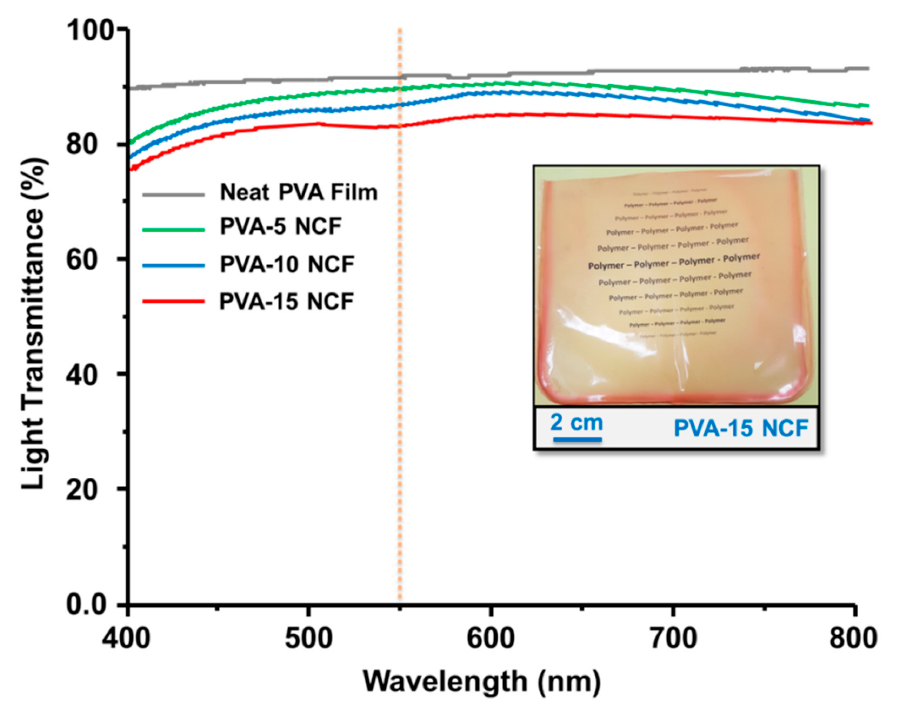
Figure 12. Transmittance for the prepared NCFs. The inset image shows the digital image for the PVA-15 NCFs placed on the top of yellow Xerox paper printed with “Polymer” words. Color parameters for the prepared NCFs at selected pH values are listed in Table 3. The lightness of the NCFs (L*) is almost constant and provides an indication about the absence of color degradation in both acidic and alkaline medium, which reflects the stability of the anthocyanin color at the entire pH range. The a* parameter has positive and high values in the acidic medium in the range of pH 3 to pH 6, where the NCF exhibits red color at pH 3–4 and pink color at pH 5–6 (Figure 13). When the